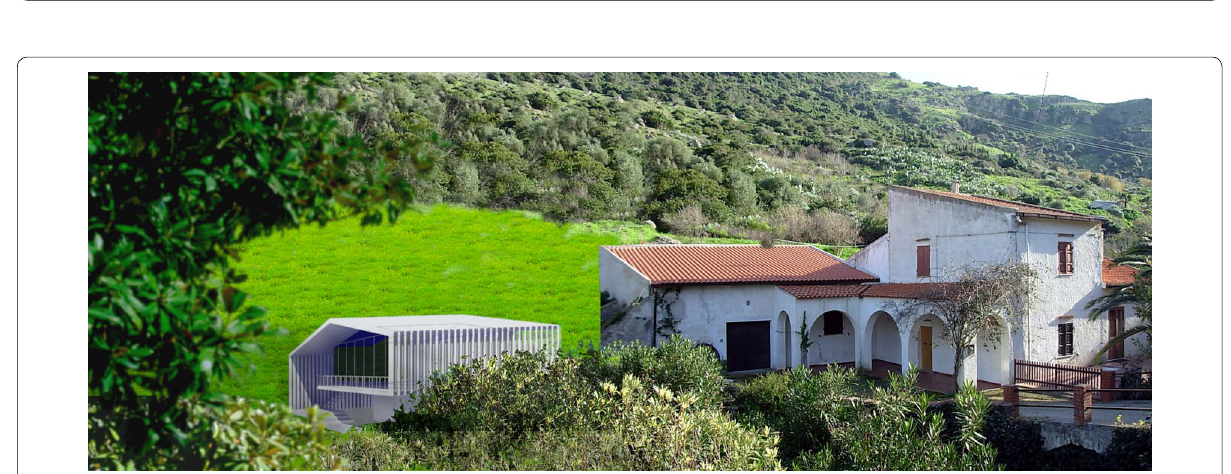
Fig. 3 Rendering of the speed-out hotel prefabricated